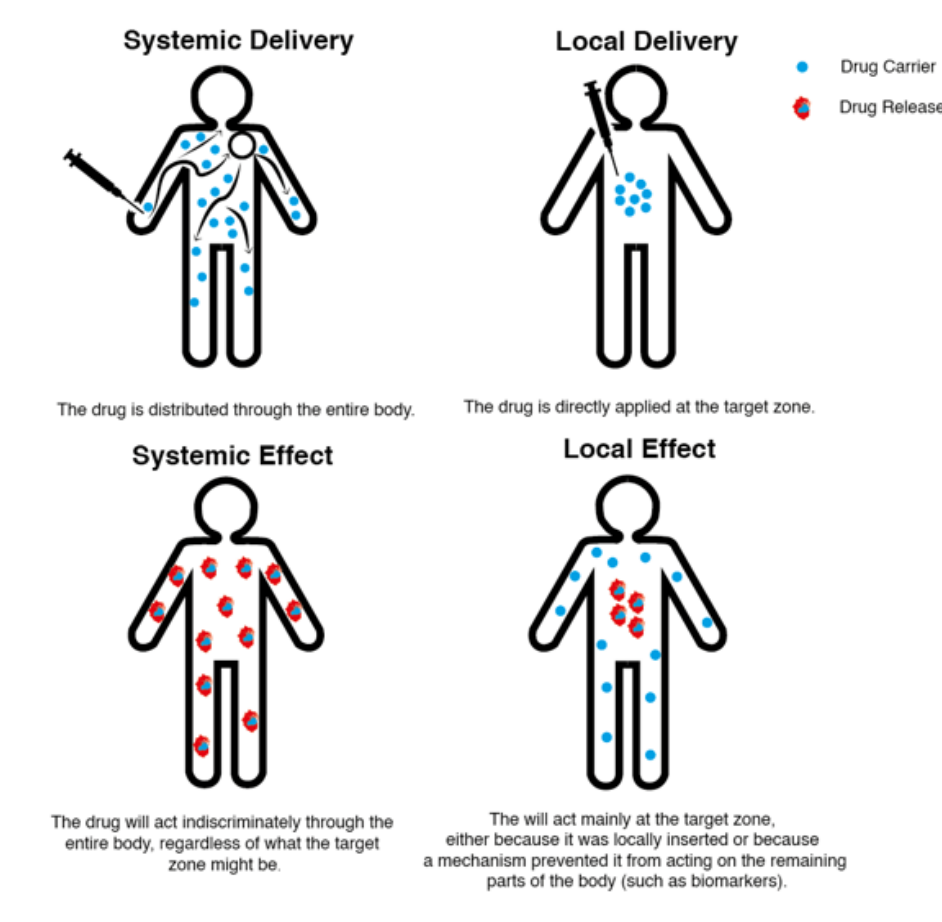
Figure 1. Illustration of the differences between systemic and local drug delivery systems and